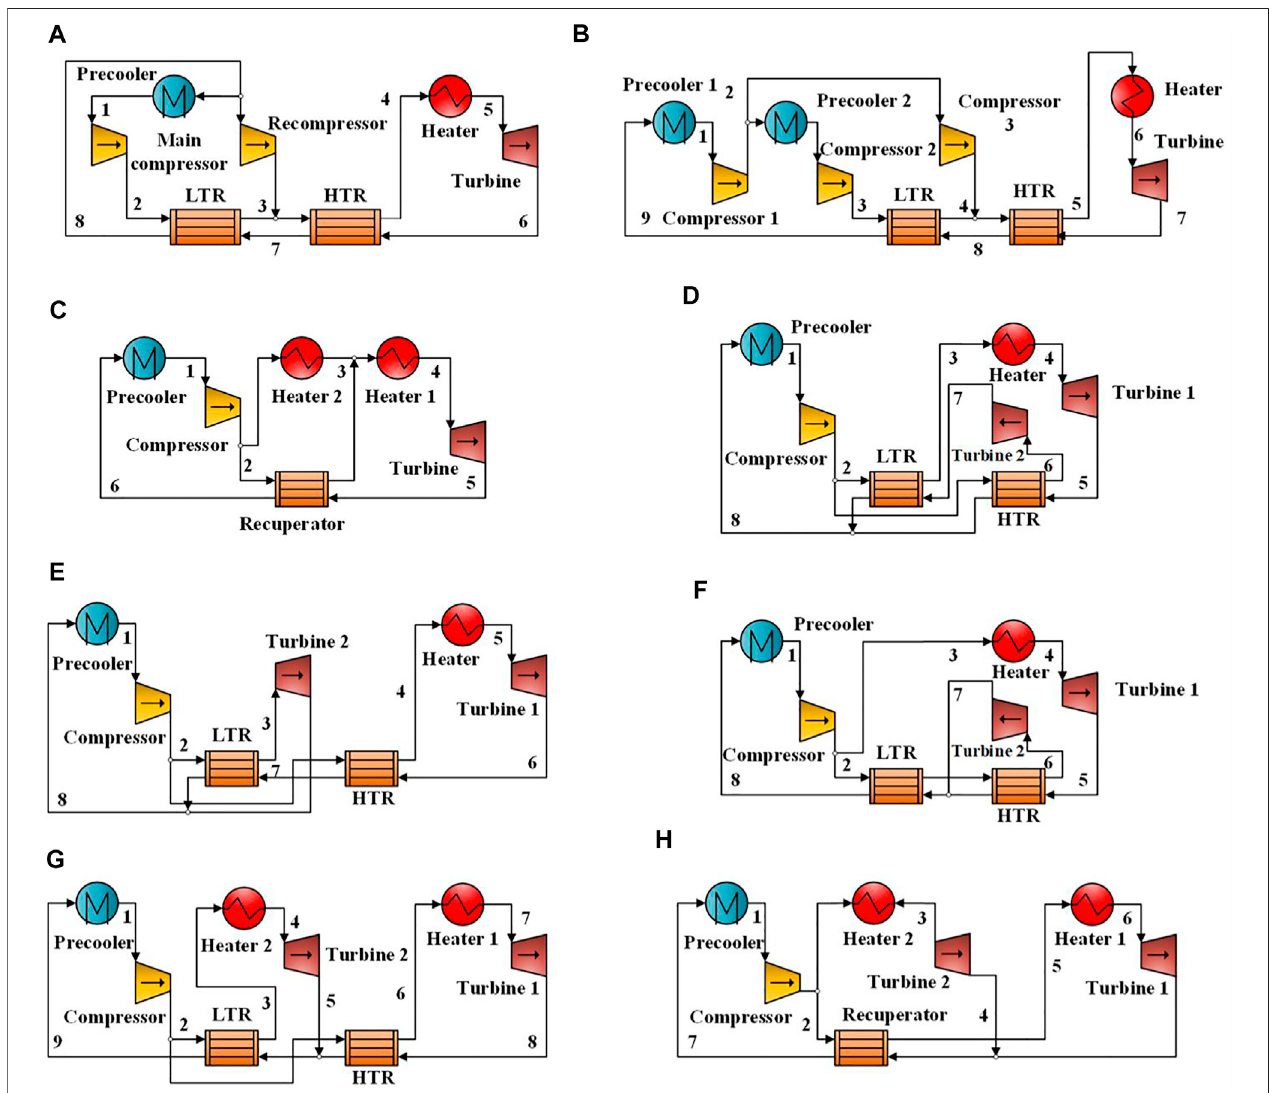
FIGURE3| Con fi gurationsofsplit- fl owsCO 2 Brayton cycles: (A) Recompression; (B) Modi fi edrecompression; (C) Pre-heating; (D) Turbinesplit fl owI; (E) Turbine split fl ow II; (F) Turbine split fl ow III; (G) Turbine split fl ow IV; (H) Turbine split fl ow V (adapted from (Ahn et al., 2015)).